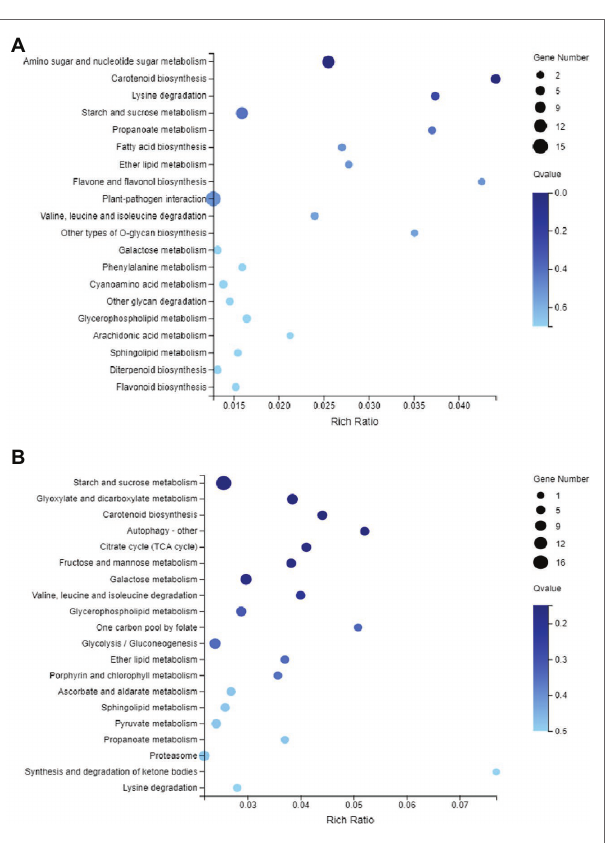
FIGURE 6 | Kyoto Encyclopedia of Genes and Genomes (KEGG) pathway enrichment analysis of DMEG. (A) KEGG of genes in the differentially methylated region (DMR)-associated promoters. (B) KEGG of genes in the DMR-associated genes, and the color of the circle represents the Q -value (corrected p